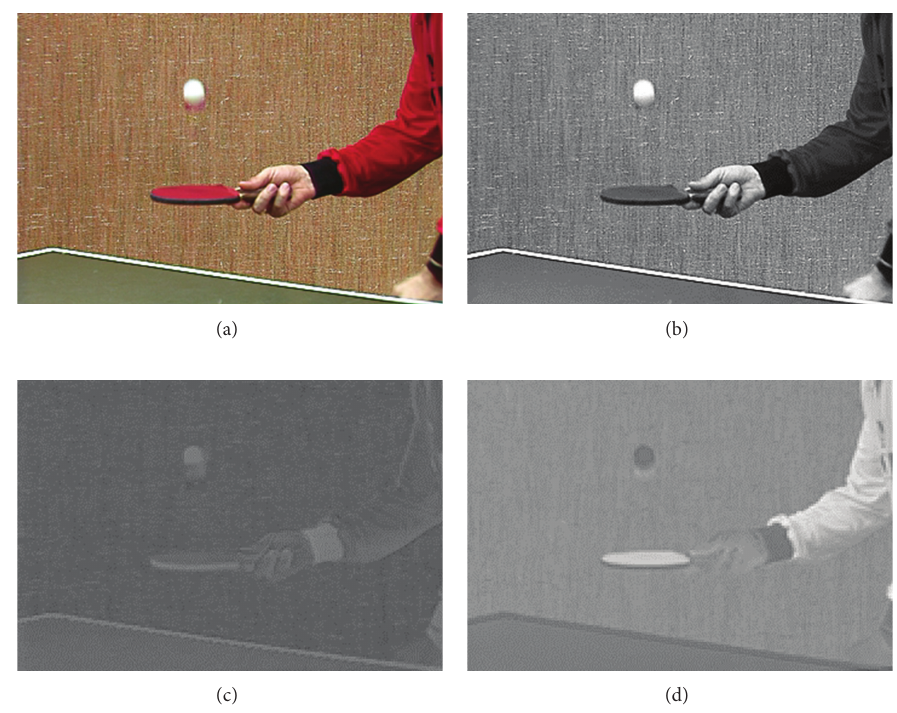
Figure 1: (a) Frame 1 of “tennis2” [6], (b) Frame 1 in 𝑌 band, (c) Frame 1 in 𝑈 band, and (d) Frame 1 in 𝑉 band.